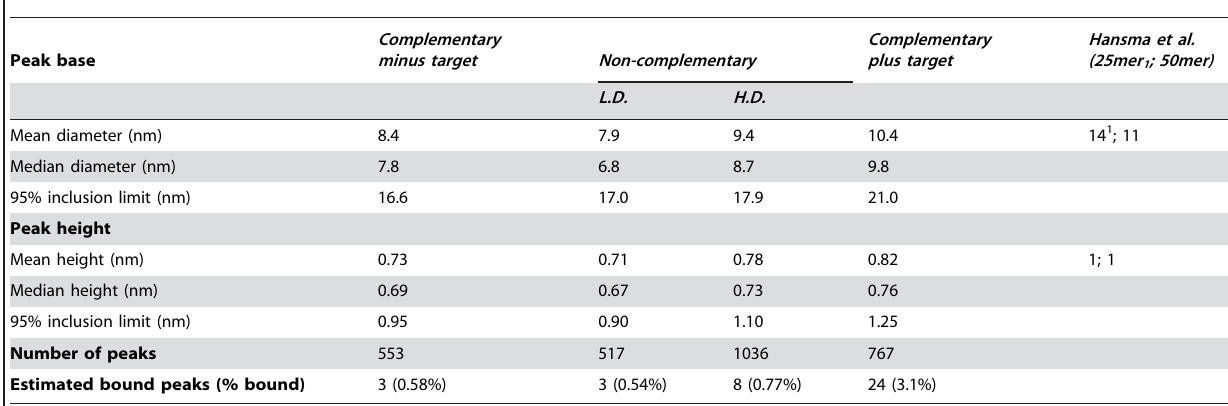
Table 2. Peak attributes of atomic force microscopy